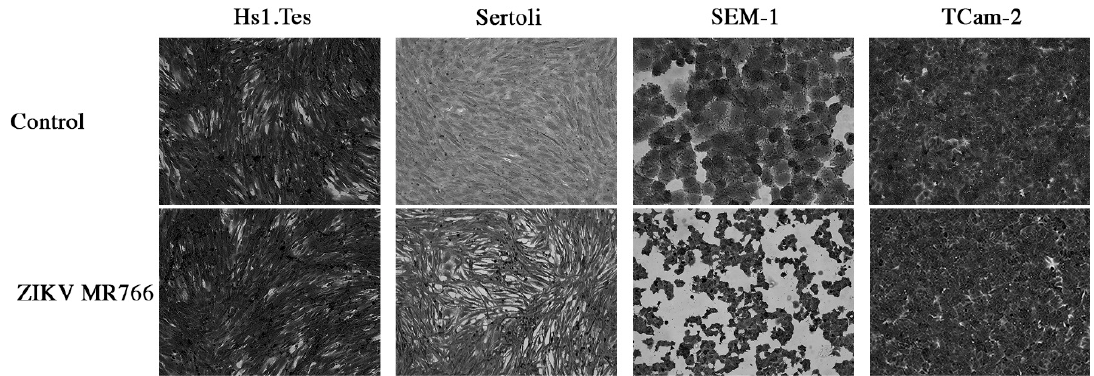
Figure 3. Cytopathic effect of ZIKV MR766 on testicular cell lines at 7 dpi. We noted that ZIKV MR766-infected Sertoli and SEM-1 cells appeared smaller than uninfected controls. TCam-2 and Hs1.Tes cells did show any CPE at 7 dpi. Images were obtained at a magnification of 400 ×